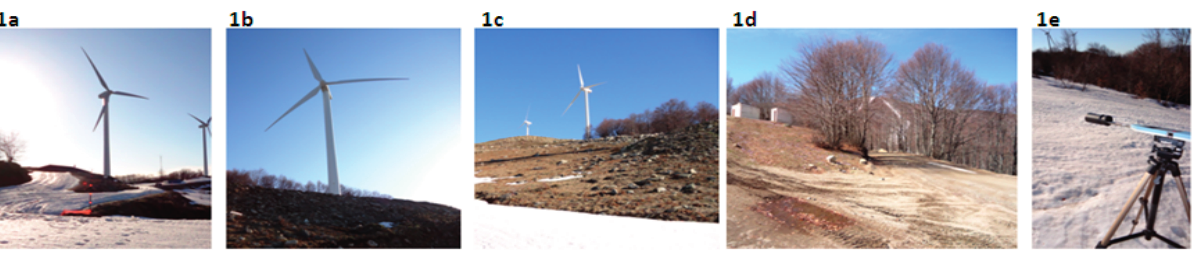
Figure 1. Pictures of the recording positions at: ( a ) 150 m; ( b ) 200 m; ( c ) 1500 m; ( d ) >2500 m. In ( e ) is shown the calibration of the sound level meter in situ .